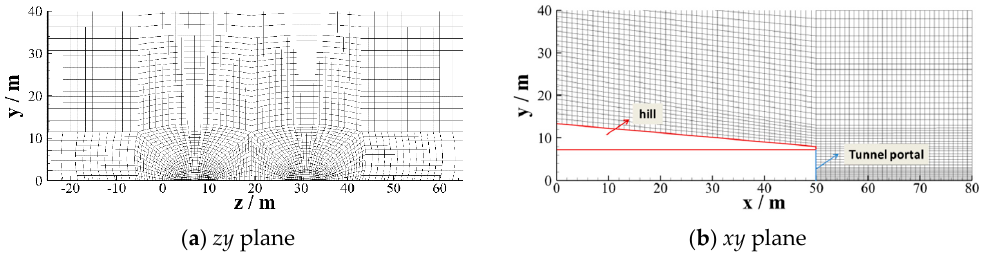
Figure 2. Schematic diagram of gird.